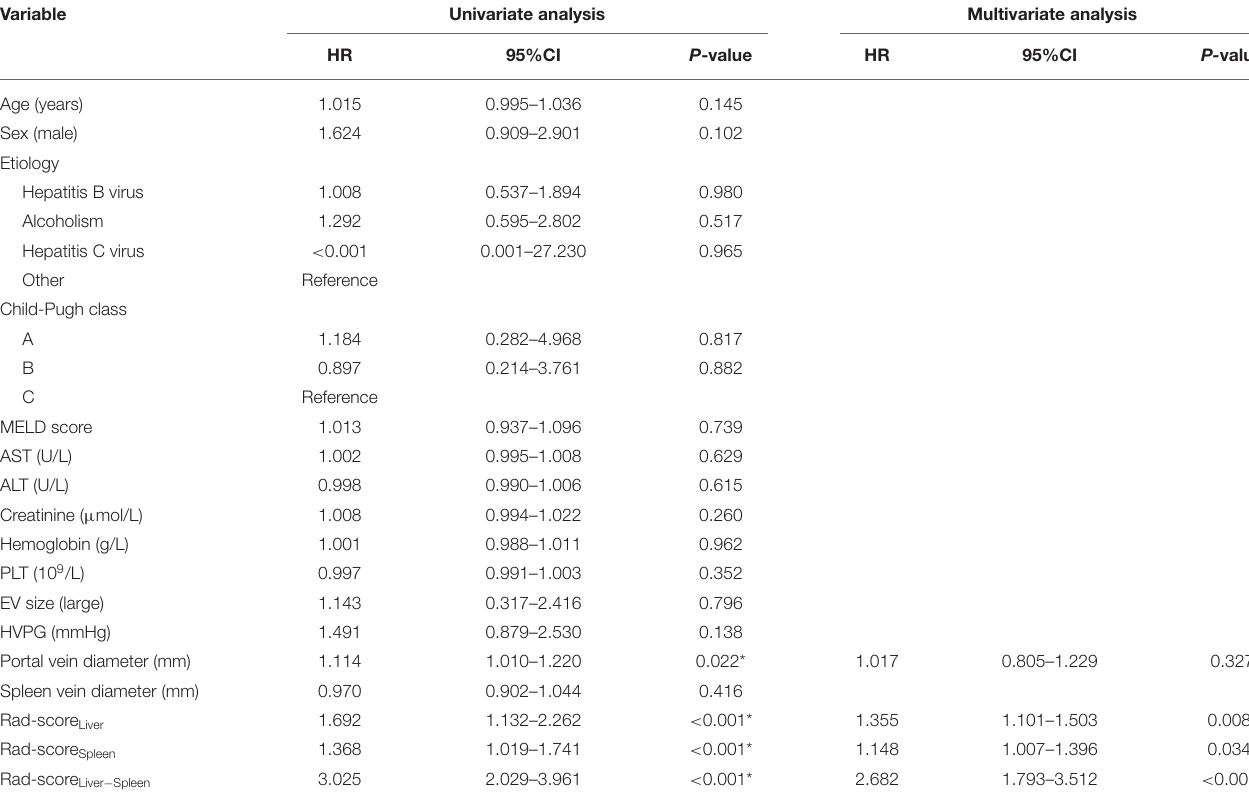
TABLE 2 | HR analysis of clinical characteristics and Rad-scores for predicting EV rebleeding.